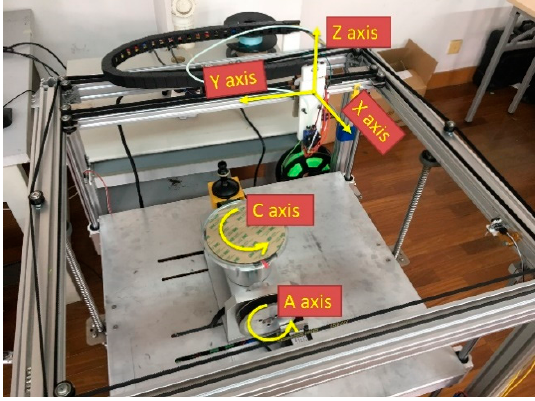
Figure 15. 5-axis 3D printing platform.